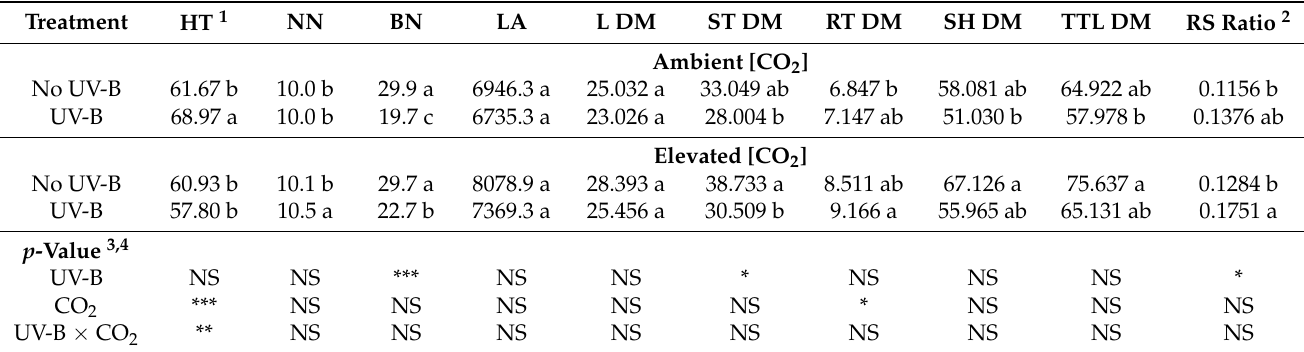
Table 2. The height (HT), node number (NN), branch number (BN), leaf area (LA), leaf dry mass (L DM), stem dry mass